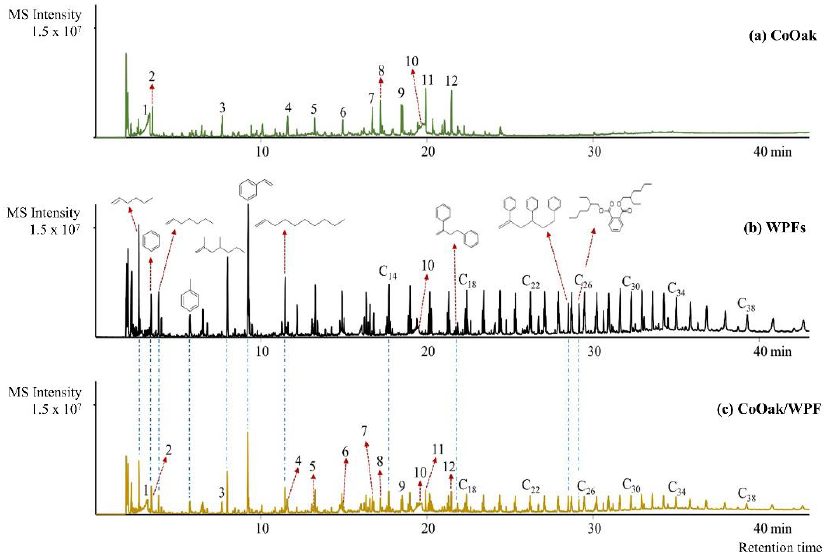
Figure 2. Pyrograms obtained from non-catalytic pyrolysis of ( a ) CoOak; ( b ) WPFS; and ( c ) CoOak/WPFS. (1: acetic acid, 2: 1-hydroxy-2-propanone, 3: furfural, 4: 5-(Hydroxymethyl)dihydro- 2(3H)-furanone, 5: guaiacol, 6: creosol, 7: vinylguaiacol, 8: syringol, 9: isoeugenol, 10: levoglucosan, 11: vinylsyringol, 12: propenylsyringol).